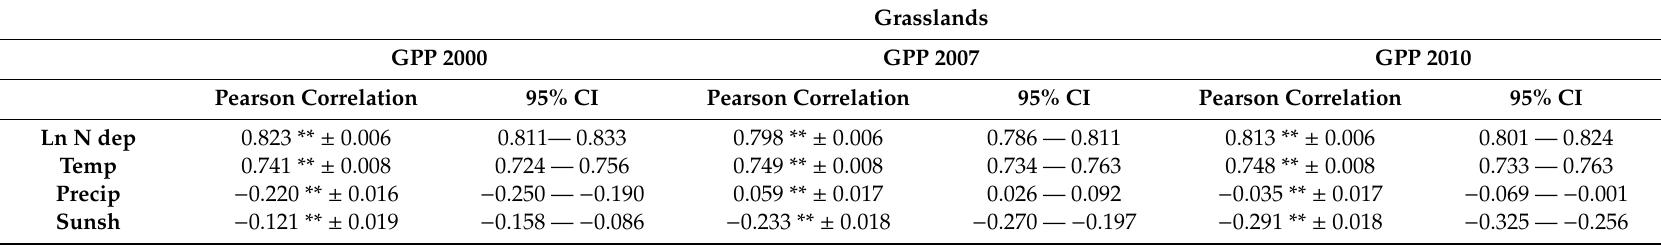
Table A1. Pearson’s correlation between GPP: Gross primary productivity and Ln N dep: Natural logarithm of N deposition, Temp: Temperature, Precip: Precipitation, and Sunsh: Sunshine, based on a bootstrap of 1000 samples per land cover class and year. ** Statistically significant p < 0.01.